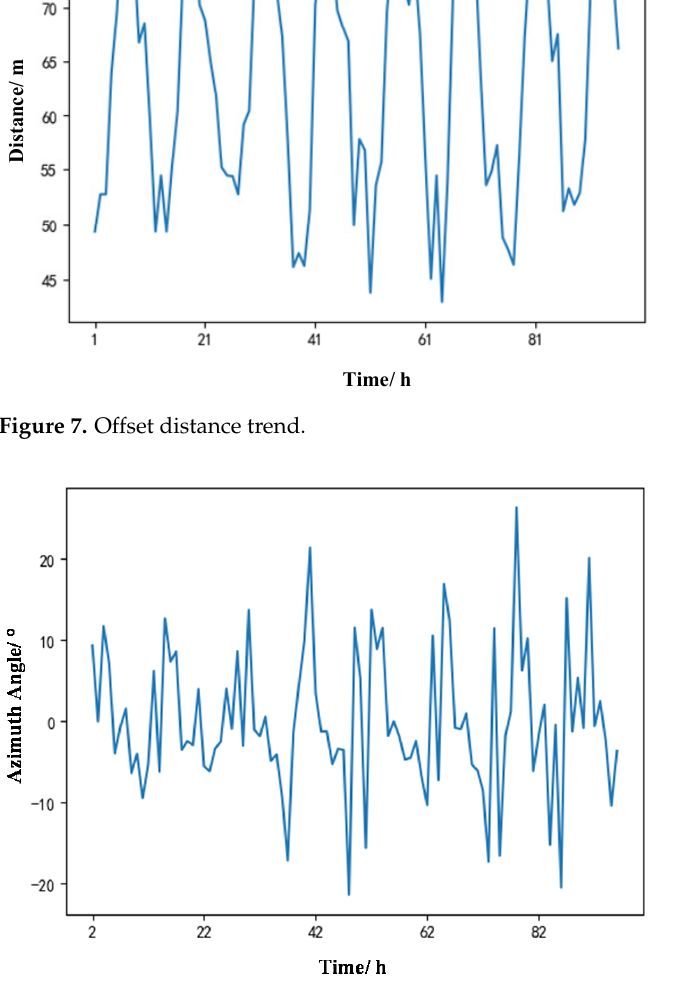
Figure 8. The first-order difference of offset azimuth.